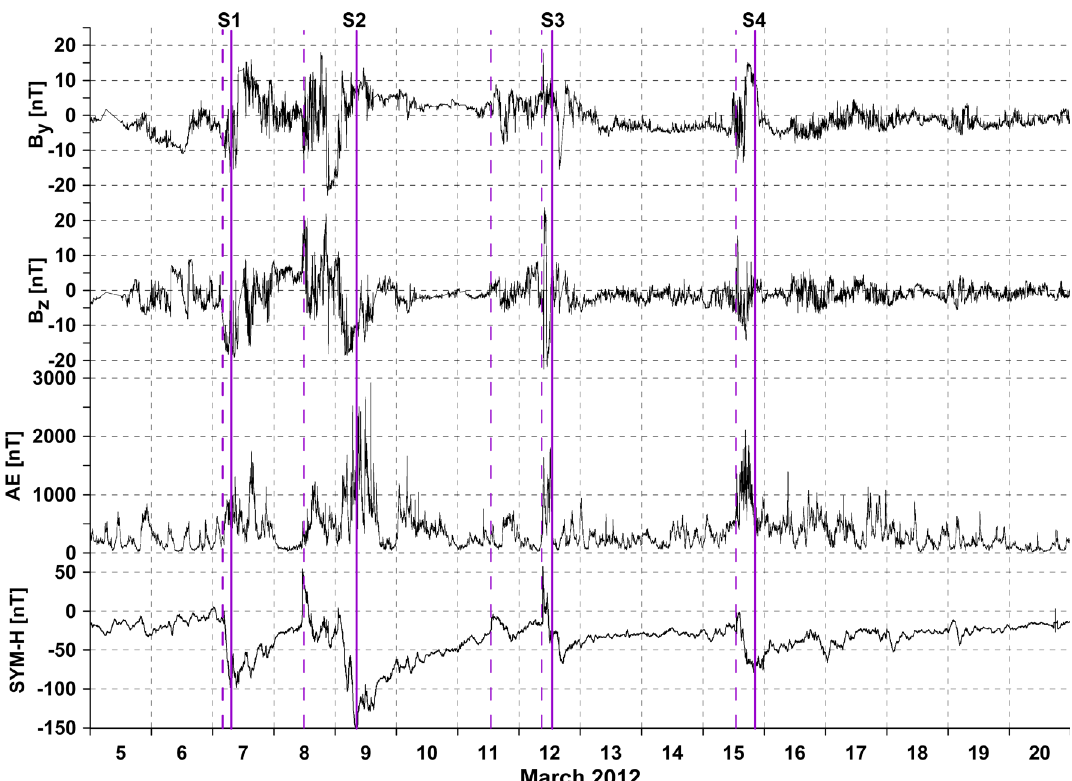
Fig. 1. The variations of the interplanetary magnetic fi eld (By, Bz) and geomagnetic parameters (AE, SYM-H) during March 5 – 20, 2012. IP shocks and minima of SYM-H index for S1 – S4 are marked with dashed and solid purple lines, respectively. The peak of the third storm is shifted according to Tsurutani et al.